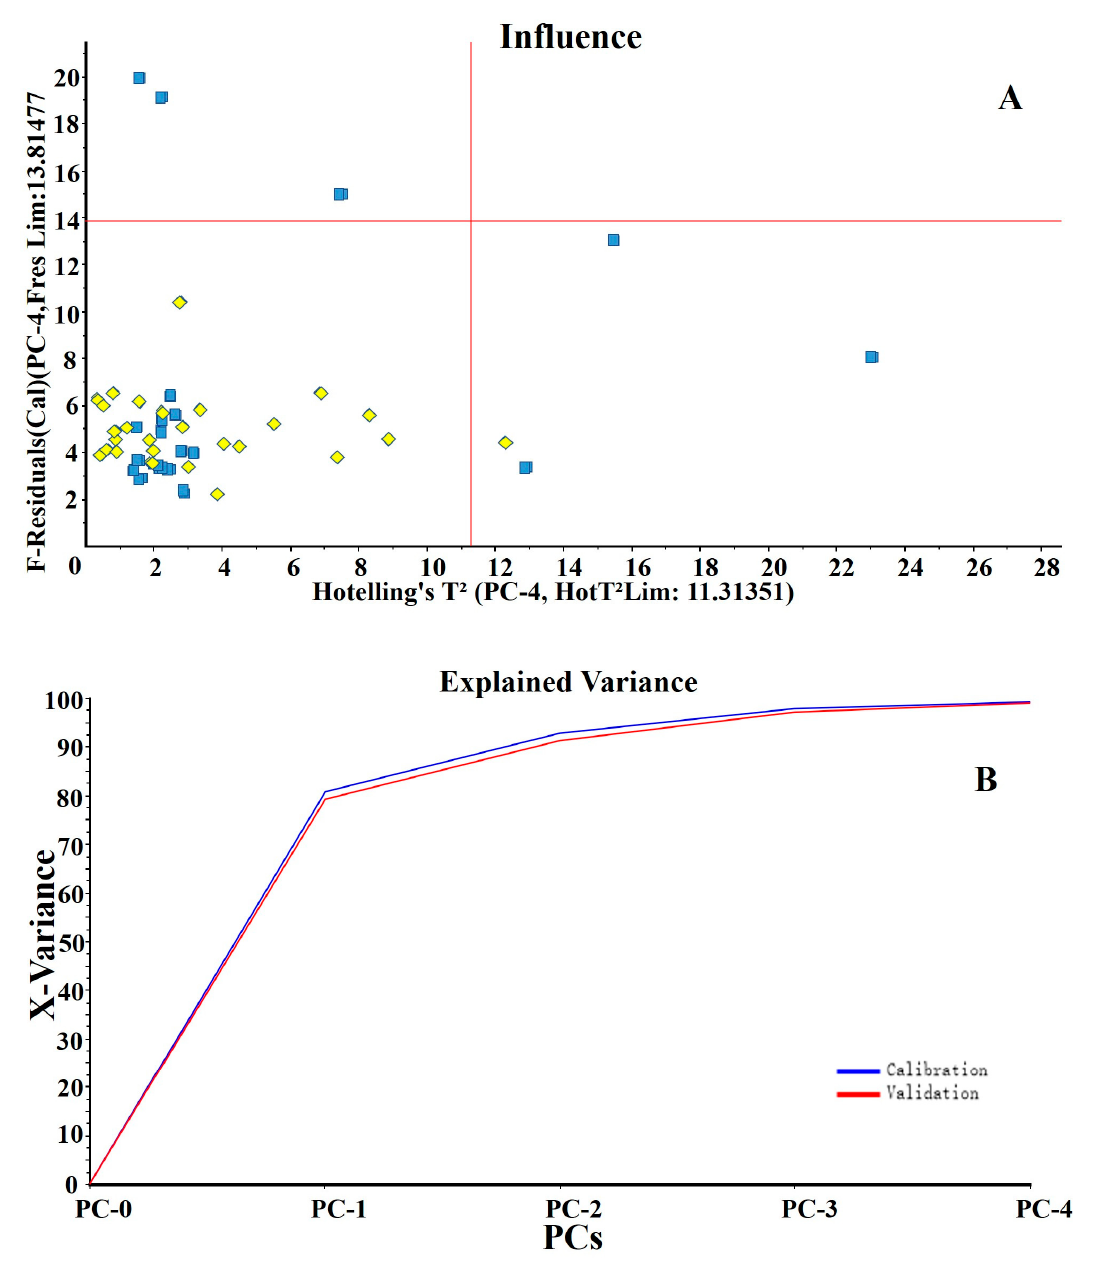
Figure 3. Hotelling’s T test results and cumulative interpretable variance of the principal components of orange juice samples. ( A ) Influence plotting. The sweet orange juices are marked in yellow diamond dots and mandarin juices are marked in blue squares. ( B ) The explained variance. The calibrated and validated curves are compared.